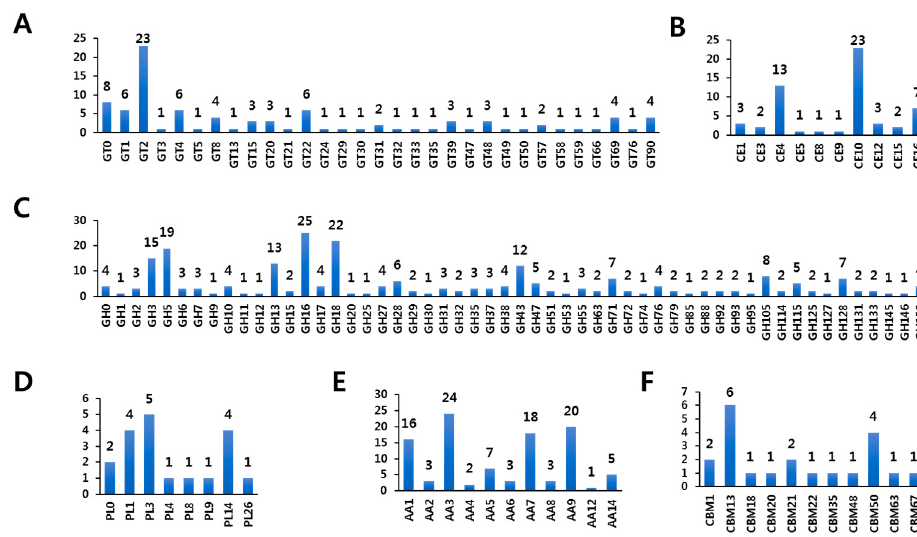
Figure 3. Number of CAZymes in F. rossica . Number of ( A ) GT families; ( B ) CE families; ( C ) GH families; ( D ) PL families; ( E ) AA families; ( F ) CBM families. AA, Auxiliary Activities; GH, glycoside hydrolase; GT, glycosyltransferase; CBM, carbohydrates-binding module; PL, polysaccharide lyase.